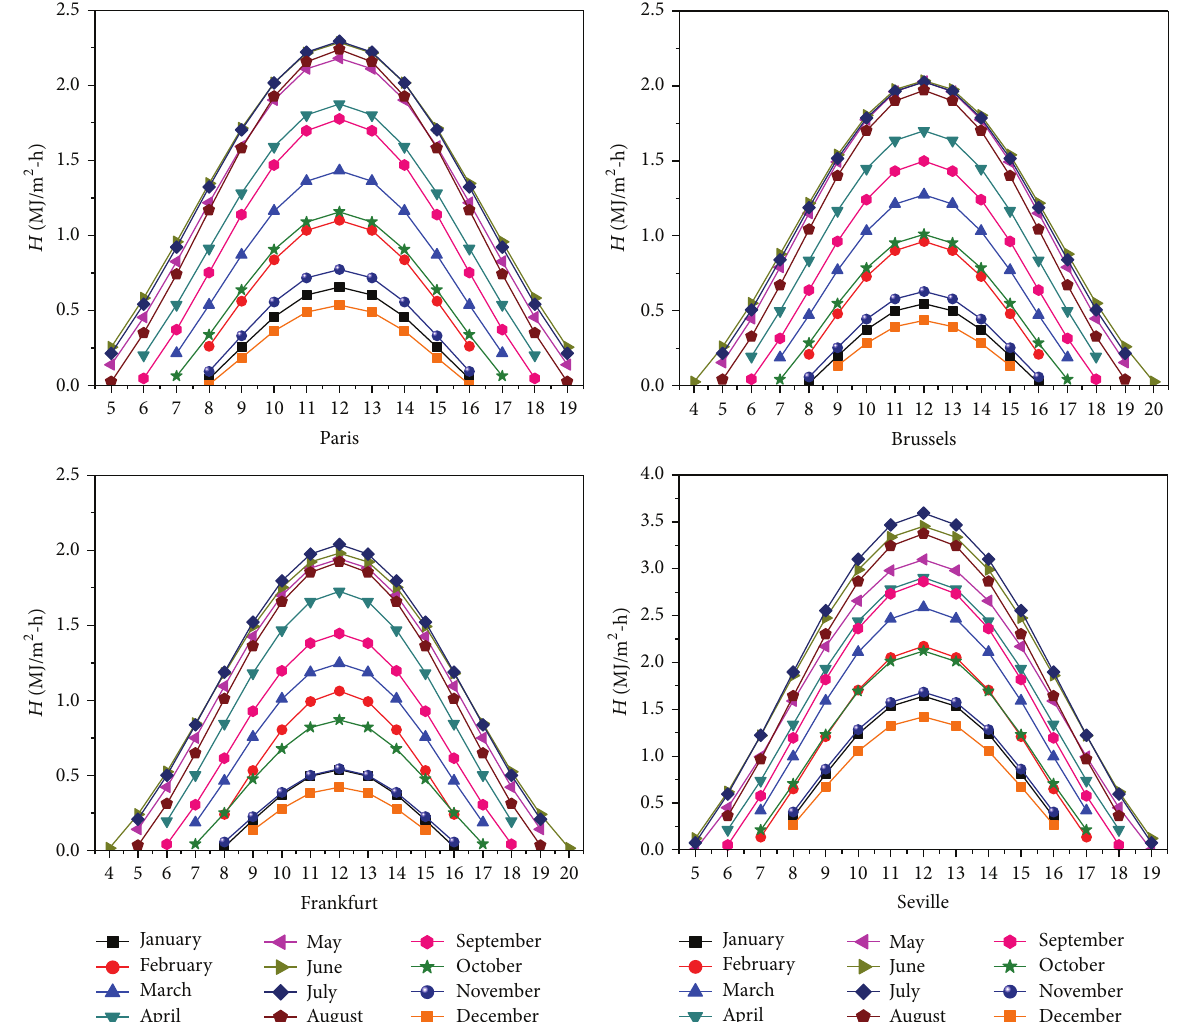
Figure 4: Hourly evolution at the 15th of the respective months in Paris, Brussels, Frankfurt, and